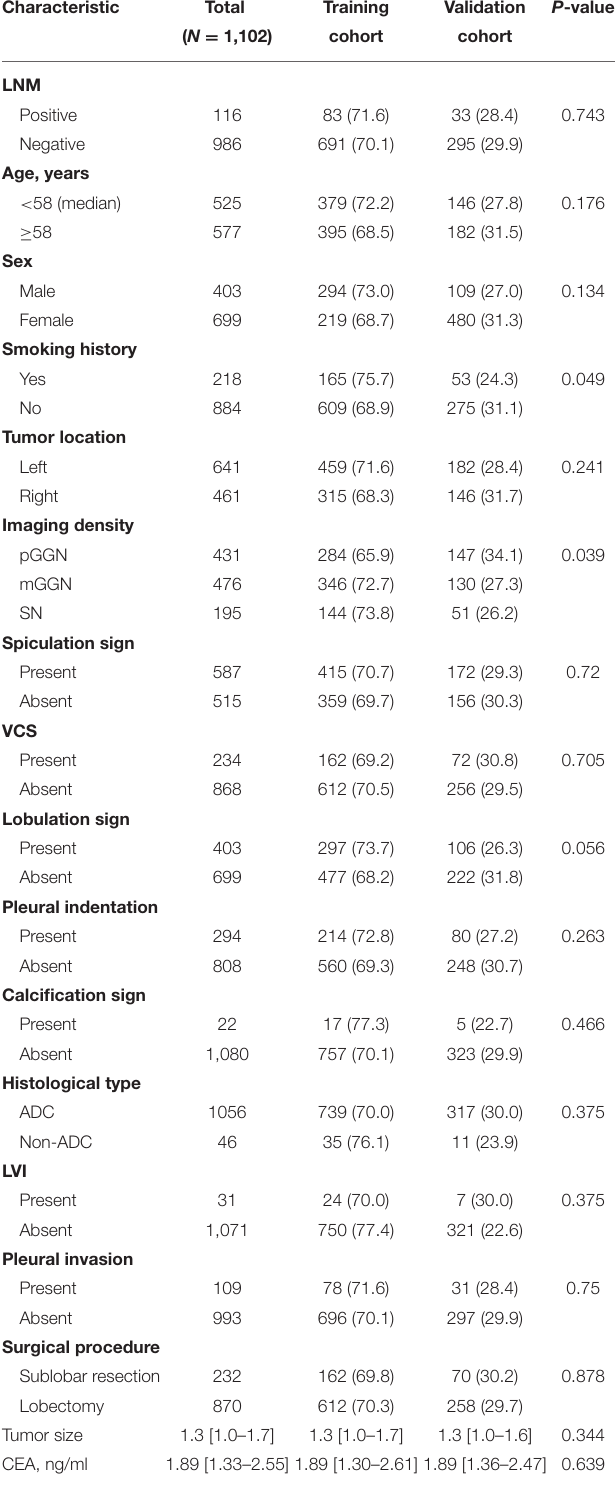
TABLE 1 | Demographic and clinicopathological characteristics in the training and validation cohorts.